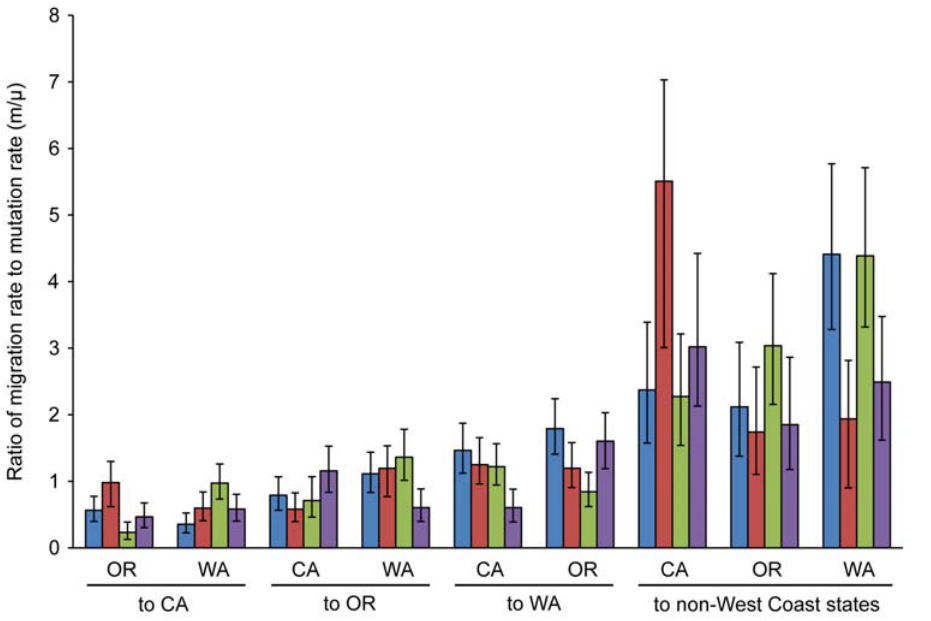
Figure 7. Estimates of relative rates of immigration to mutation (m/ m ). The ratio of immigration rate to mutation rate was estimated for each of four populations. Isolates were combined across years for CA, OR, and WA, and combined across both years and states for a population of all non- West Coast isolates. The migration model allowed the three West Coast populations to both send and receive migrants, but the fourth population to only receive immigrants. Bars show the maximum likelihood estimate of the parameter for four independent runs of the program Migrate (indicated by different colors). Error bars indicate 95% confidence intervals.